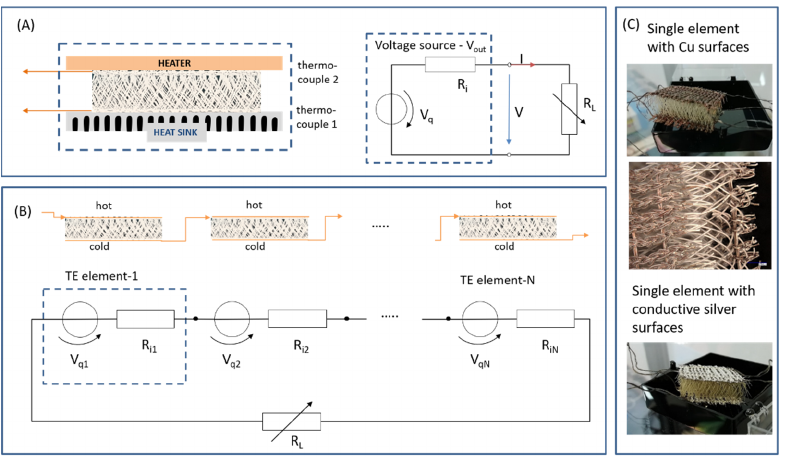
Figure 1. ( A ) Schematic description of a single textile element setup and equivalent circuit diagram for TE measurements, ( B ) circuit of several elements for applications, ( C ) CuI coated 3D fabrics with copper top and bottom surfaces and additional with a conductive silver coating on the surfaces, photos and microscope image (digital microscope KEYENCE VHX7000) in the middle.